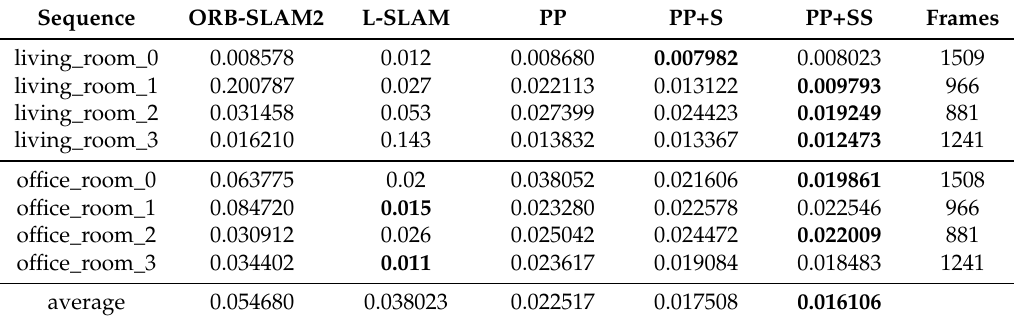
Table 1. Evaluation results of translation absolute trajectory error (ATE) root mean squared error point-plane SLAM using structural constraints, point-plane SLAM using structural constraints and supposed planes, respectively. Bold numbers represent the best